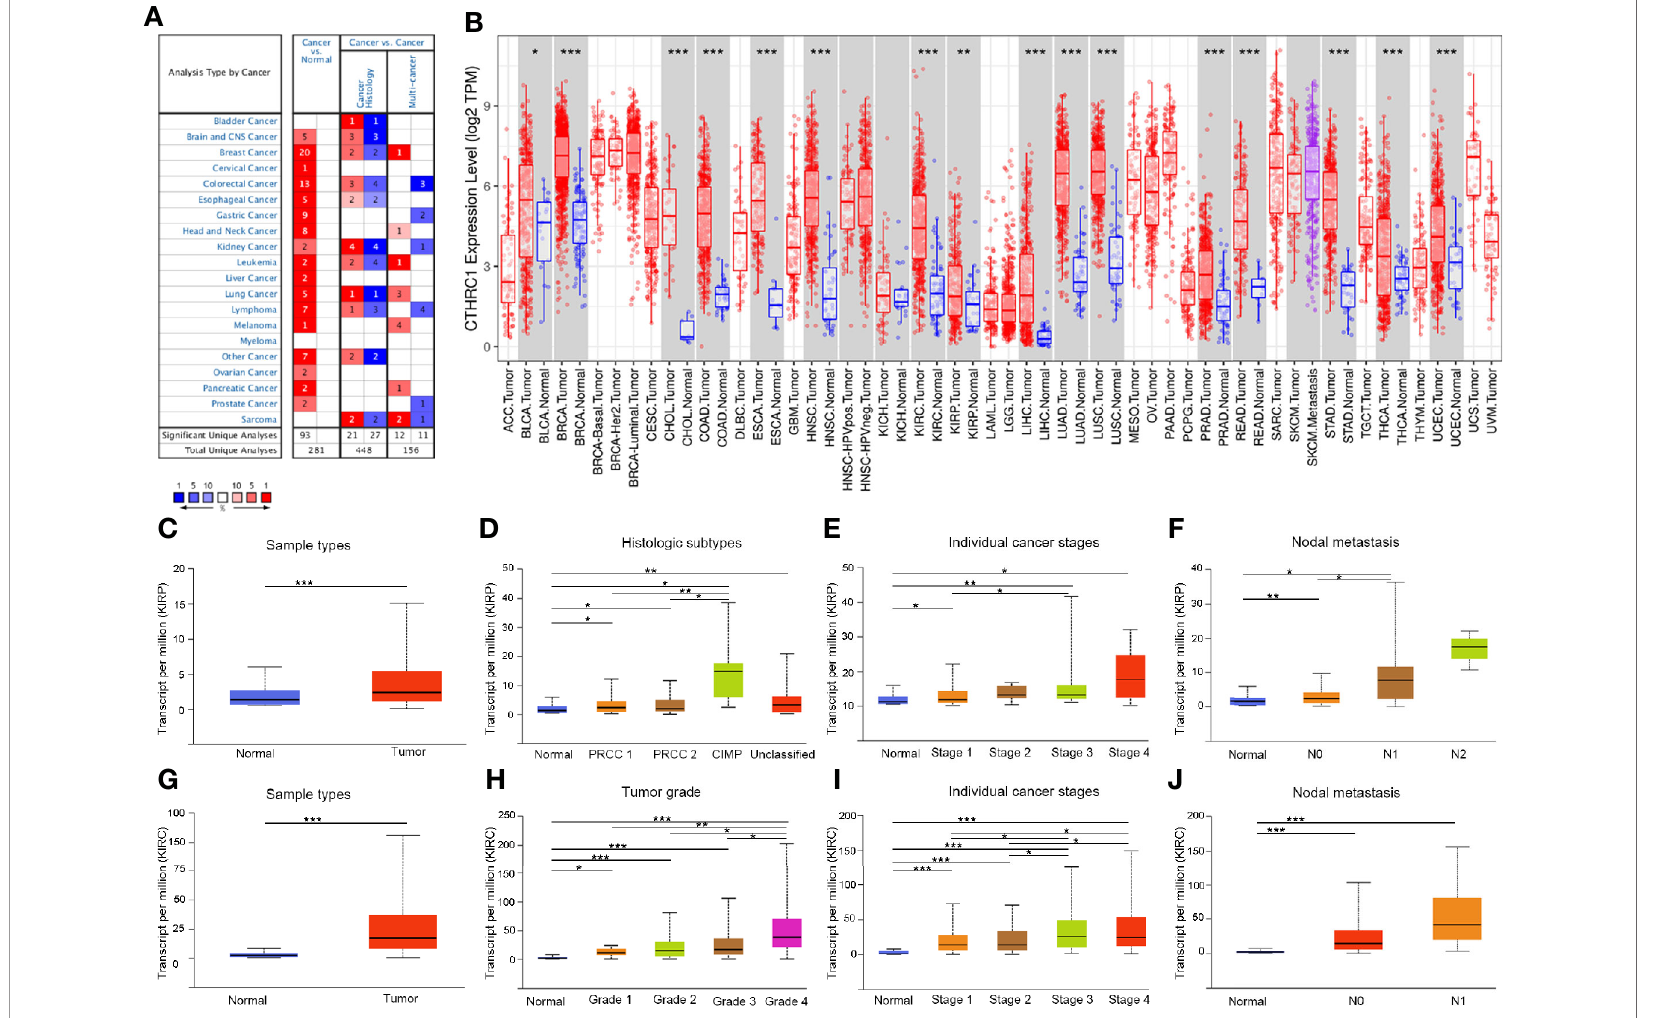
FIGURE 1 | The expression of CTHRC1 in different cancers and its relationship with individual clinical parameters of KIRP and KIRC. (A) CTHRC1 level in different cancers tissues compared to normal tissues in the Oncomine database. (B) CTHRC1 expression of different tumor types in the TIMER database. (C) CTHRC1 expression difference in KIRP samples. (D – F) CTHRC1 mRNA expressions were remarkably correlated with KIRP patients ’ individual cancer histologic subtypes (D) , stages (E) , nodal metastasis (F) . (G) Differential expression of CTHRC1 in KIRC tissues. (H – J) CTHRC1 level were signi fi cantly associated with KIRC patients ’ individual cancer grade (H) , stages (I) , nodal metastasis (J) . N0: Metastases in 1 to 3 axillary lymph nodes, N1: Metastases in 1 to 3 axillary lymph nodes, N2: Metastases in 4 to 9 axillary lymph nodes. *p<0.05, **p<0.01,